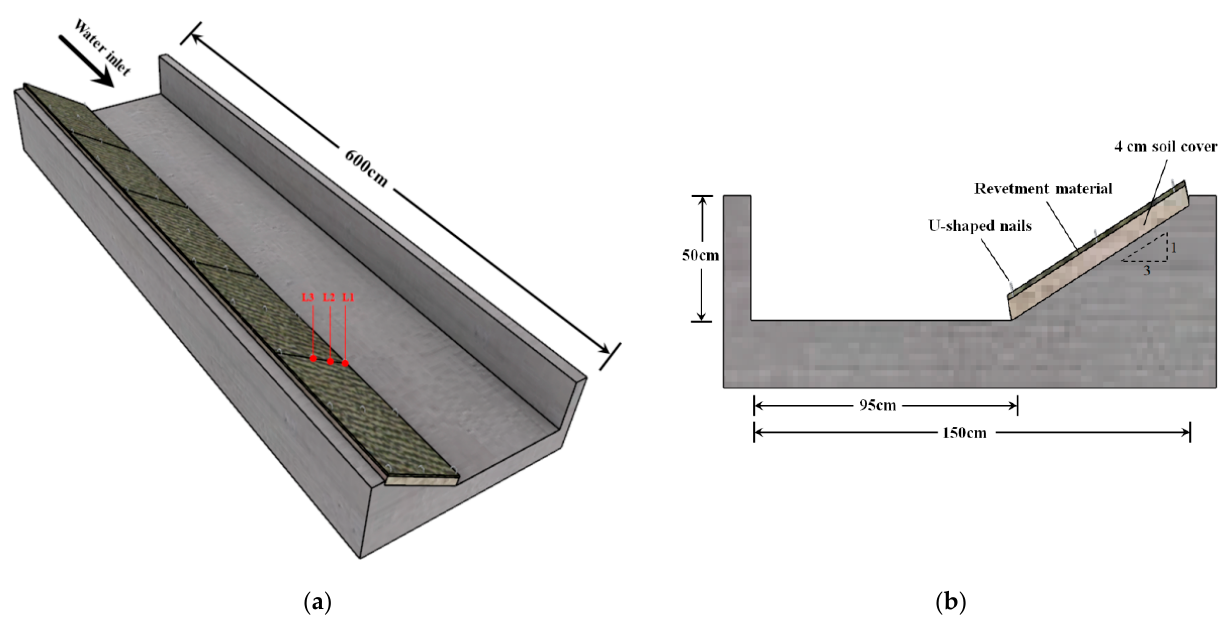
Figure 1. Schematic diagram of the experimental flume: ( a ) aerial view; ( b ) dimensions of cross section.